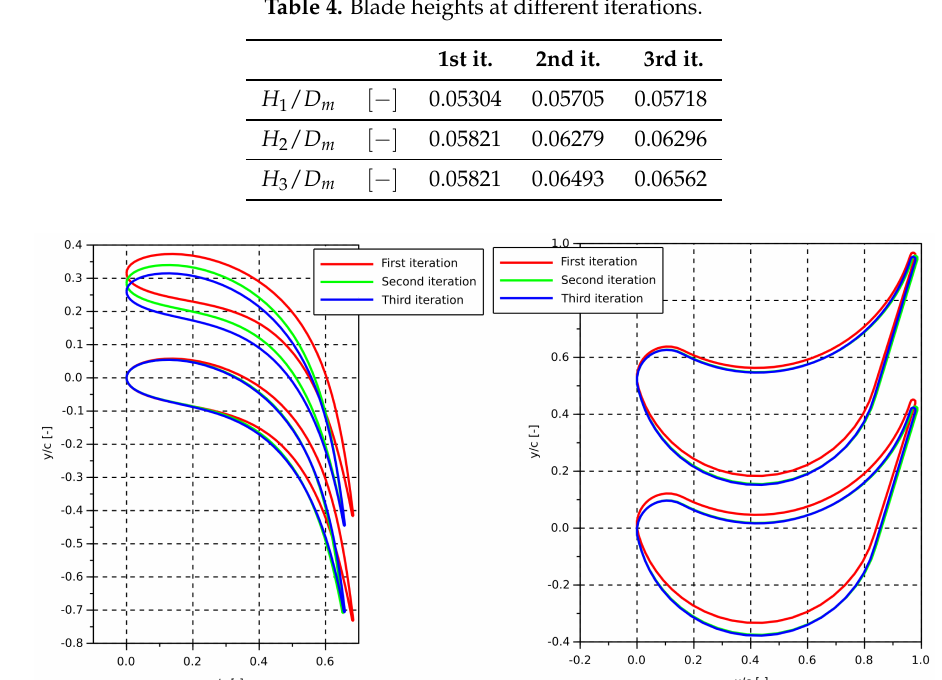
Table 4. Blade heights at different iterations.